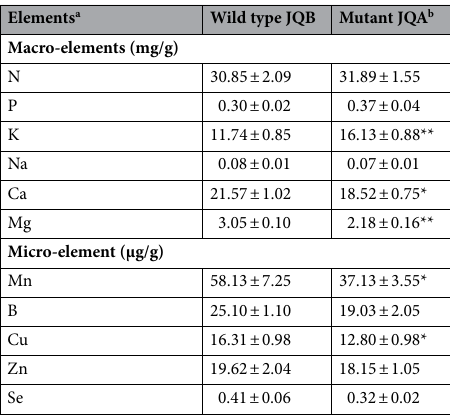
Table 3. The contents of macro- and micro-elements in sesame leaves. a N nitrogen, P phosphorus, K potassium, Na sodium, Ca calcium, Mg magnesium, Mn manganese, B boron, Cu copper, Zn zinc, Se selenium. b Values are means ± standard deviation ( n = 3). Data in the same row followed by * and ** are significantly ( P < 0.05) and very significant ( P < 0.01) different,